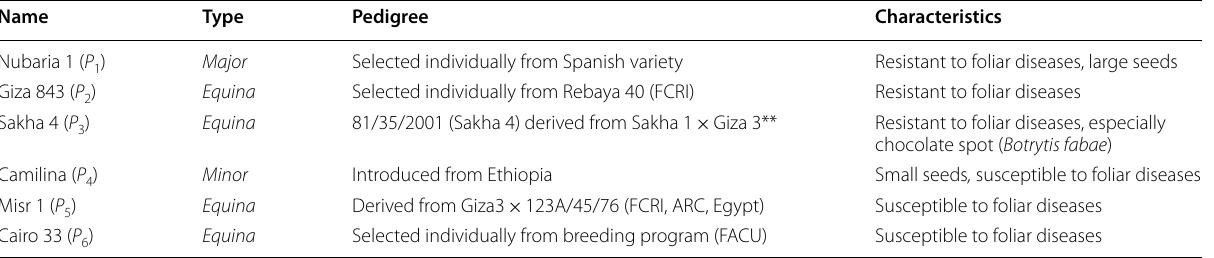
FCRI Field Crops Research Institute, FACU Faculty of Agriculture, Cairo University (see Abdalla 2015 for details) (*see Muratuva